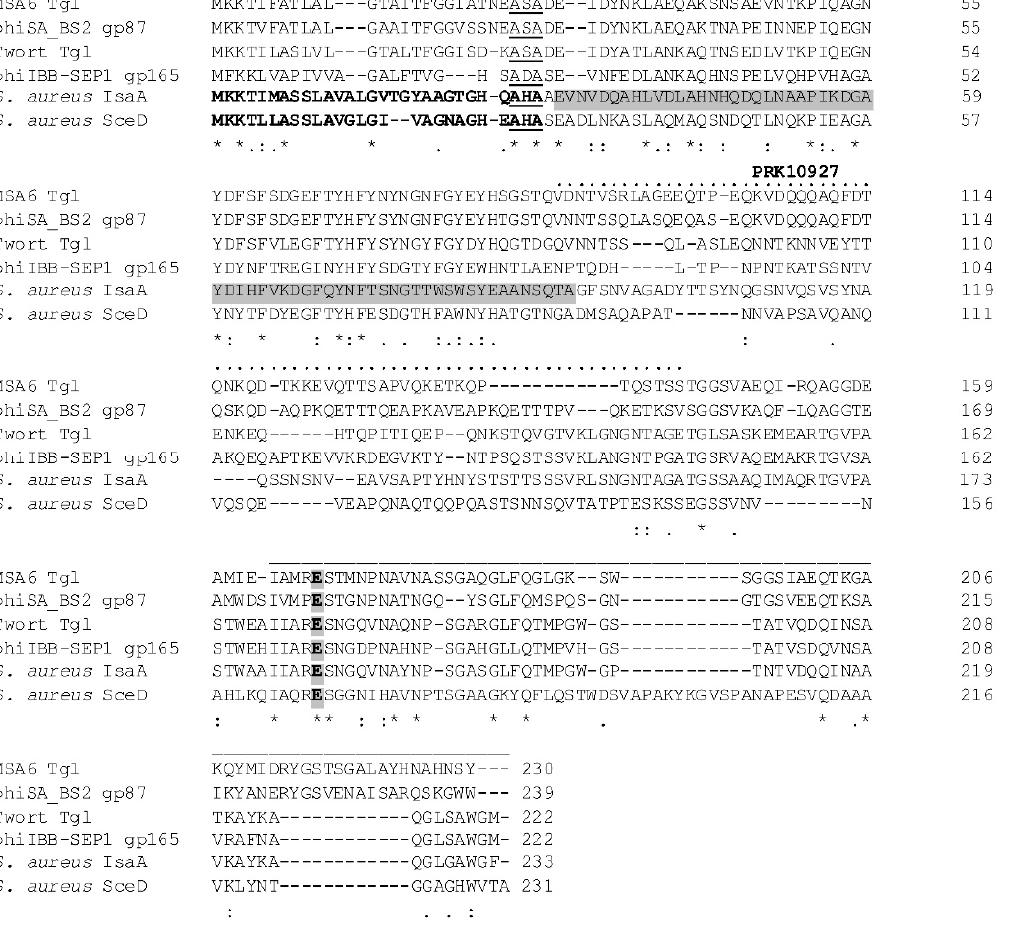
Figure 1. Alignment of amino acid sequences of MSA6 Tgl and its homologs encoded by type phages of Baoshanvirus , Twortvirus , and Sepunavirus genus [5,77,78] with S. aureus SceD and IsaA. The Clustal Omega program (CLUSTAL O (1.2.4), https://www.ebi.ac.uk/Tools/msa/clustalo/) [79] served to make the alignment. Protein designations are the following: Tgl- AFN38714,